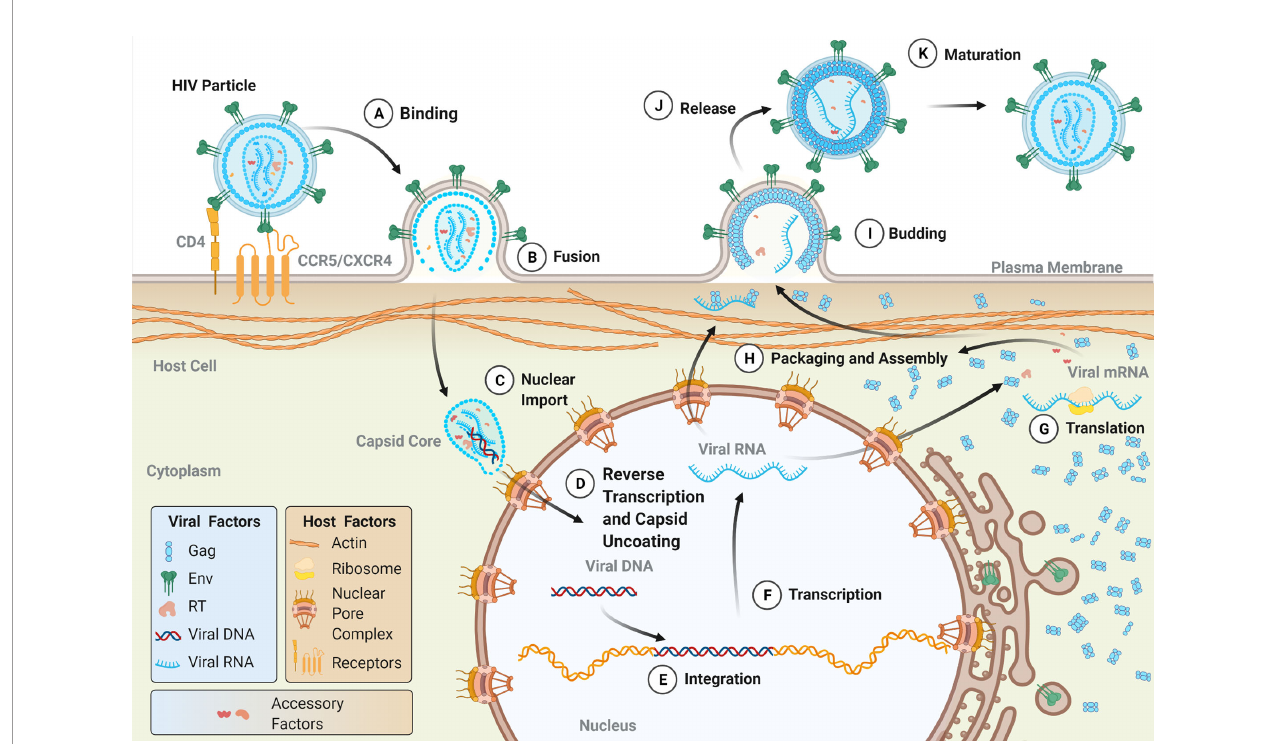
FIGURE 2 | The lifecycle of human retroviruses. The major steps of the retroviral lifecycle are shown. Viral proteins are colored according to those used in the genomic structure diagram in Figure 1 . (A) The retroviral lifecycle begins when the envelope proteins of a mature, infectious virion attach to the appropriate receptor (for HIV-1, CD4) and co-receptor (CCR5 or CXRC4) on the surface of the cell, which facilitates viral membrane fusion with the plasma membrane. Following release into the cytoplasm (B) , the intact (or near intact) capsid core is traf fi cked to nuclear pore complexes (NPCs) on the nuclear envelope. During or shortly after nuclear import (C) , capsid uncoating and reverse transcription occur (D) (see Figure 3 for more details on reverse transcription). The double-stranded DNA product is subsequently integrated into the host genome by integrase (E) . Host machinery transcribes the proviral genome (F) into both the viral genomic RNA (vRNA) and mRNA, which templates the translation of viral proteins both in the cytosol and on the surface of the ER, with co-translational insertion of the transmembrane Env protein occurring in the ER (G) . A milieu of viral and host proteins traf fi cs along with vRNA to the plasma membrane where they are packaged into nascent budding particles (H) . Following the budding (I) and release of the particle from the plasma membrane (J) , the viral protease cleaves Gag resulting in the formation of a mature, infectious particle (K)